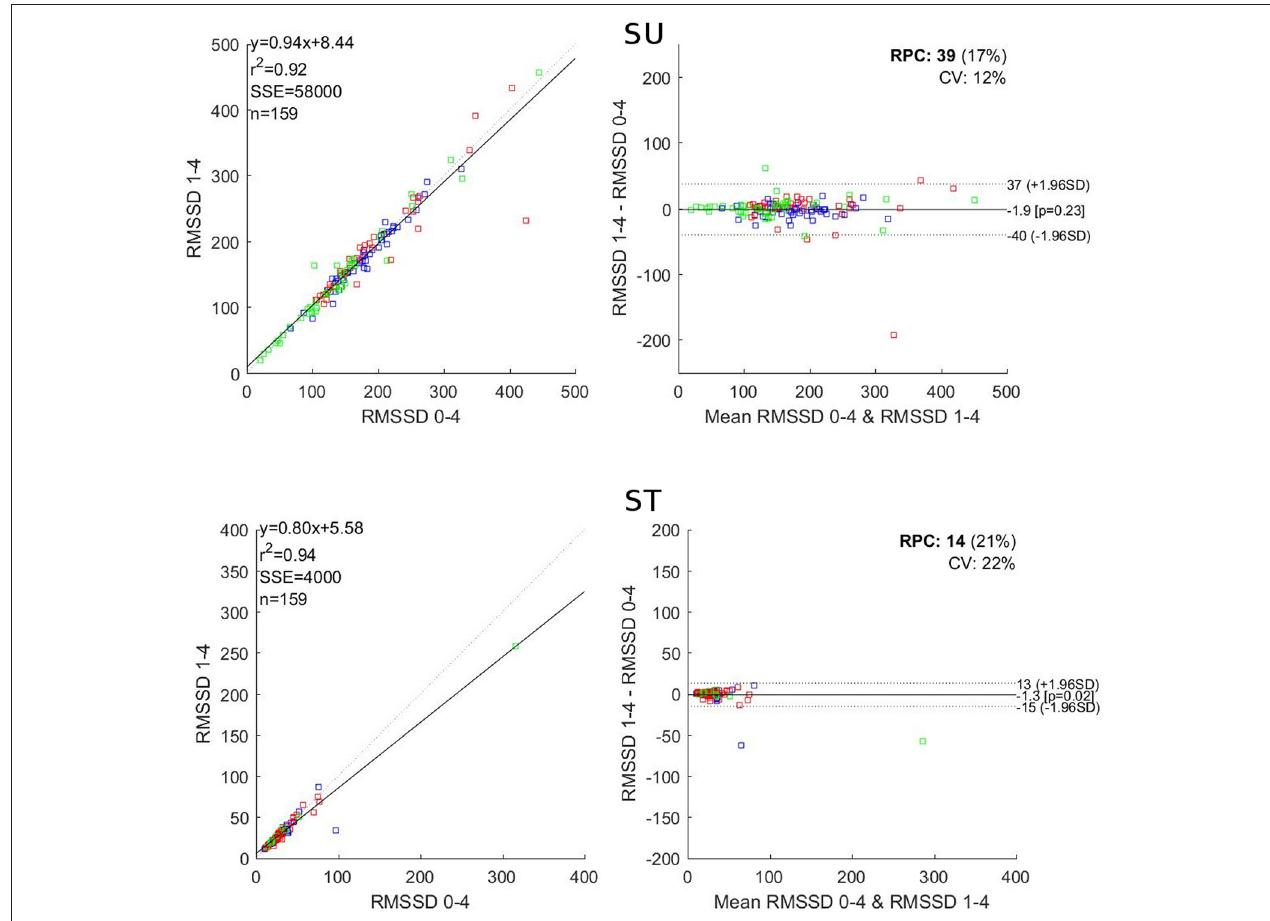
FIGURE 2 | Correlation (Left) and Bland and Altman (Right) plots for comparison of RMSSD in the 1–4 and the reference 0–4 windows. SU, supine; ST, standing; r 2 , Pearson r square; SSE, sum of square error; RPC, reproducibility coefficient; CV, coefficient of variation. Blue dots: Subject 1; red dots Subject 2; green dots: Subject